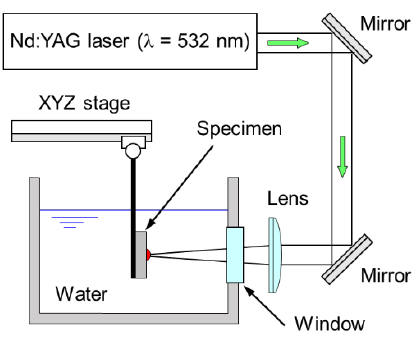
Figure 1. Experimental setup for underwater laser irradiation.